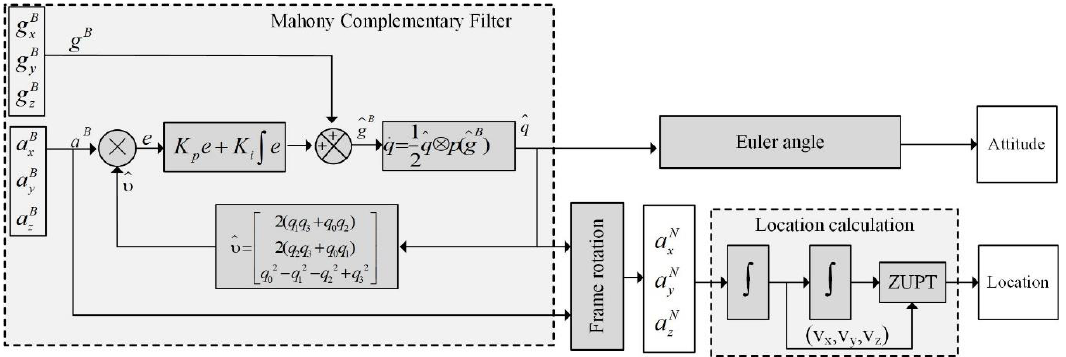
Figure 5. Schematic diagram of the inertial measurement units (IMU) attitude and position estimation. ZUPT: zero velocity update.